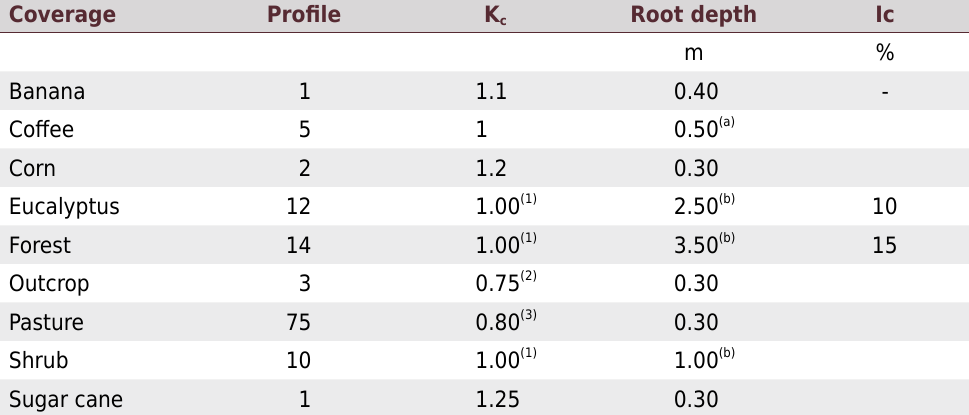
Table 1. Vegetation types and number of profiles sampled in the basin, with respective parameters adopted for the vegetation in the water balance